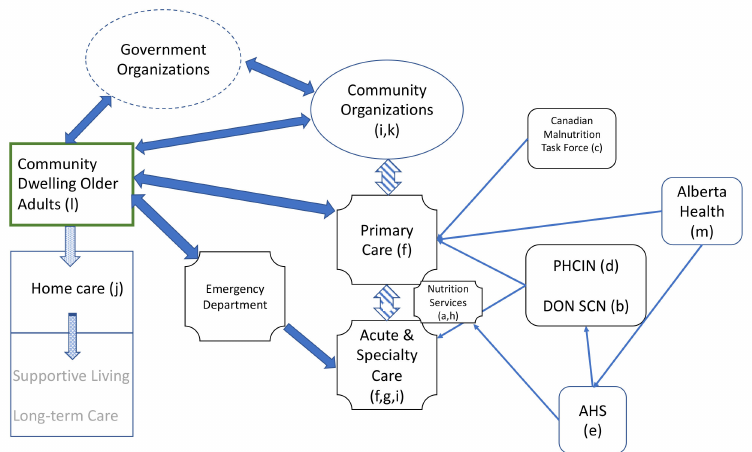
Figure 1. Constituencies of knowledge users and their connections to community-dwelling older adults (green box), the healthcare system and other organizations. Solid dark blue arrows denote di- rect interaction of older adults with the healthcare system, government and community organizations. Stippled arrows show potential progression of older adults to requirement for home care support or long-term care. Thick striped arrows indicate the relationship between acute and primary care with community organizations, which was identified by symposium participants. It was also identified that these connections could be strengthened, for example through transitions pathways from acute to primary care. Community organizations identified that many of their services could be better utilized by augmenting connectivity between themselves and primary care. Thin arrows indicate organizations that provide policy and other leadership support for implementation of best practices; Alberta Health provides operating budgets to the primary care system and AHS. Involvement of other government organizations not directly providing healthcare was not explored in depth. Letters in parentheses reference Table